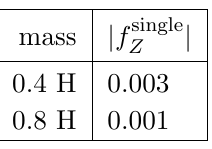
Table 7 . NG mediated by Z via single exchange diagram in e(cid:11)ective Goldstone